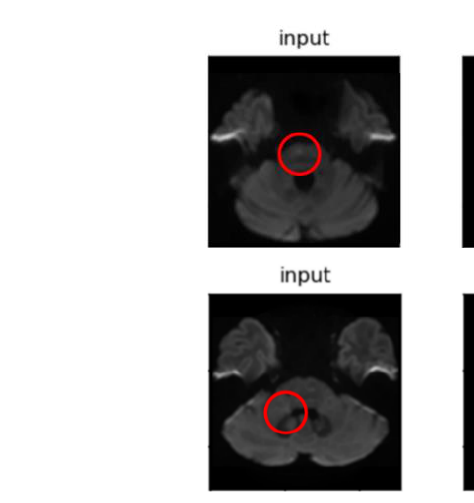
( c ) Figure 6. Visual results for ( A ) large AIS, ( B ) small AIS and ( C ) sparsely located small AIS ( TP is red, FP is green and FN is yellow) : ( a ) Expert annotation, ( b ) Predicted indirect volume, and ( c ) Predicted direct volume. In the case of direct segmentation , there was no significant performance difference in the F1-score between the estimated scratch model and the pretrained model. In the case of indirect volume estimation, the pretrained model had a higher F1-score than the scratch model. The reasons for these results are as follows: First, what the pretrained model predicts is different. In direct volume estimation, the pretrained model for auto implants predicts the shape and size of an implant through an image of a defective skull, unlike ours, which segments lesions through brain images. Moreso, the number of modalities and classes used in the pretrained model is different from ours. In direct volume estimation, brain tumor segmentation of the pretrained model is for segmenting brain tumors composed of multiple labels, like activators and edema, by inputting multimode MRI, such as FLAIR (fluid-attenuated inversion recovery), T1, and T2. This is different from our study, which involves segmenting AIS lesions by input-